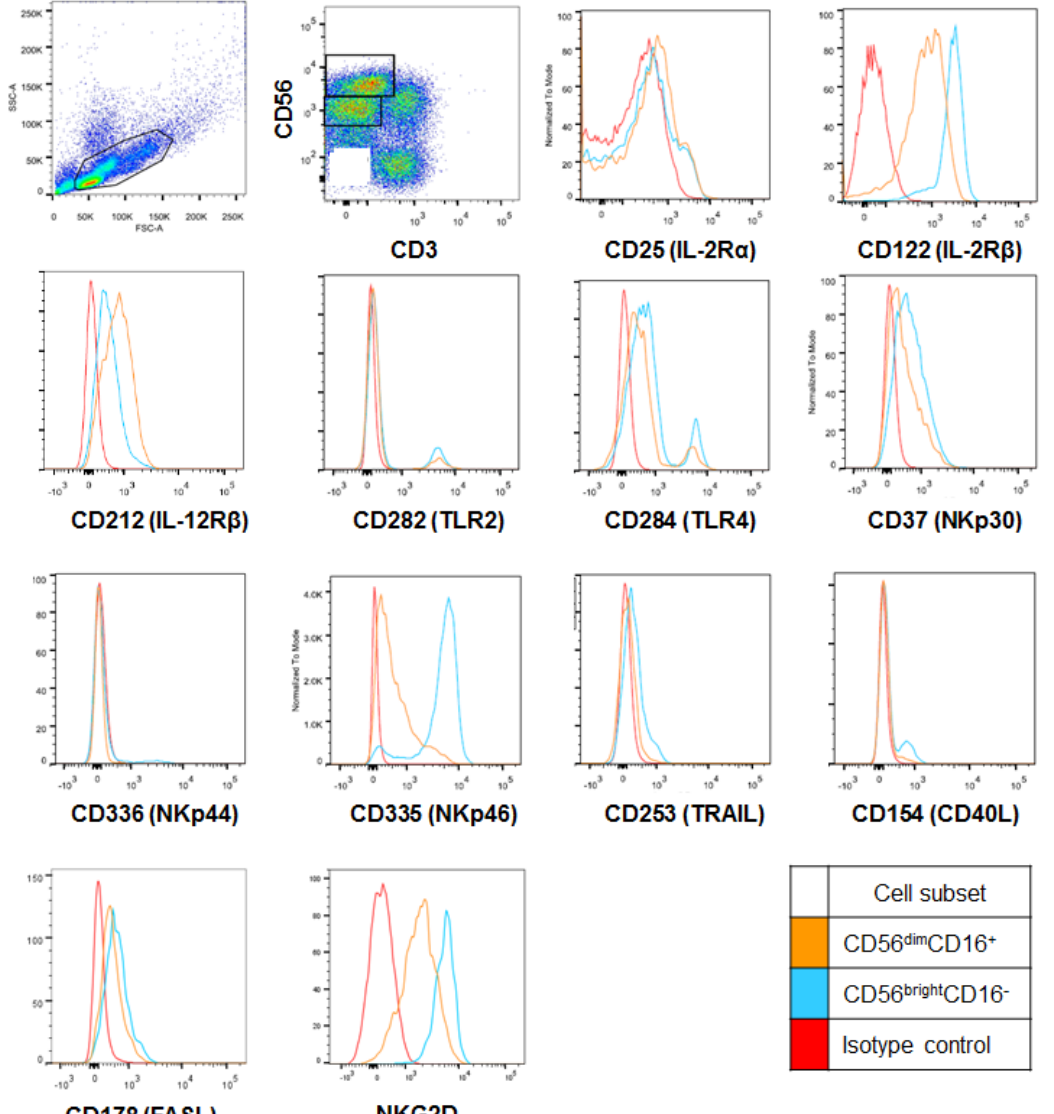
Figure 2. Comparison of cytotoxicity receptor and death ligand expression in CD56 bright vs. CD56 dim HI NK cells. CD56 bright and CD56 dim NK cells are gated as Figure 1. Representative plots of cytotoxicity and cytokine receptors and death ligands on the surface of HI NK cells are shown. n = 6 for NKG2D and 12 for all other receptors.